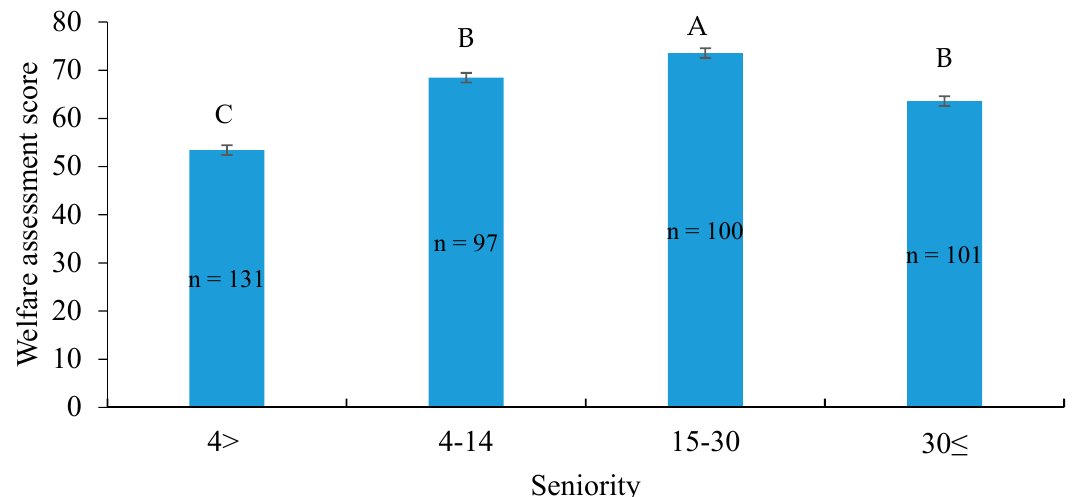
Figure 5. Effect of farm workers’ seniority (years of experience in farming) on their knowledge of animal welfare, as expressed by the welfare assessment score. Values are presented as LS mean ± SE ( n = 429; p < 0.0001). Letters “A”, “B” and “C” signify statistical differences between groups.